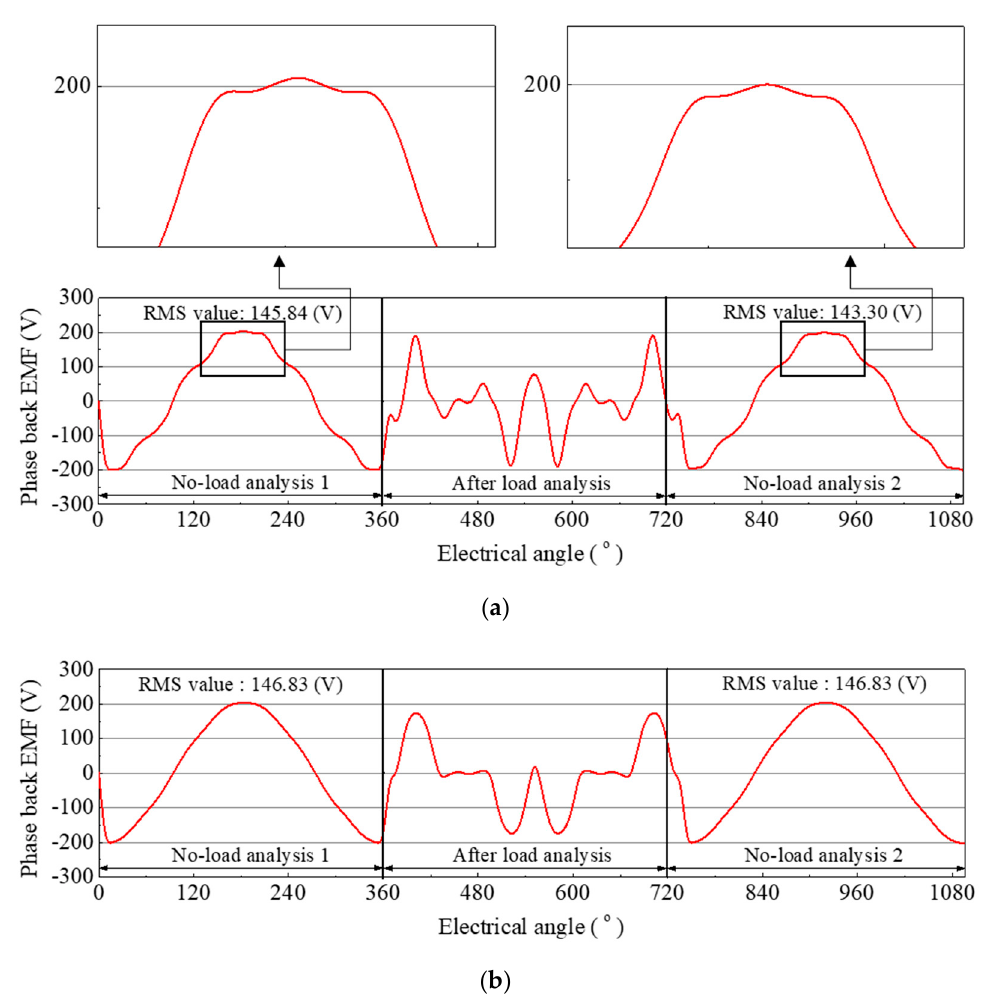
Figure 14. Results of the demagnetization analysis in each temperature: ( a ) prototype (193.3 ℃ ) ( b ) optimum model (178.7 ℃ ).